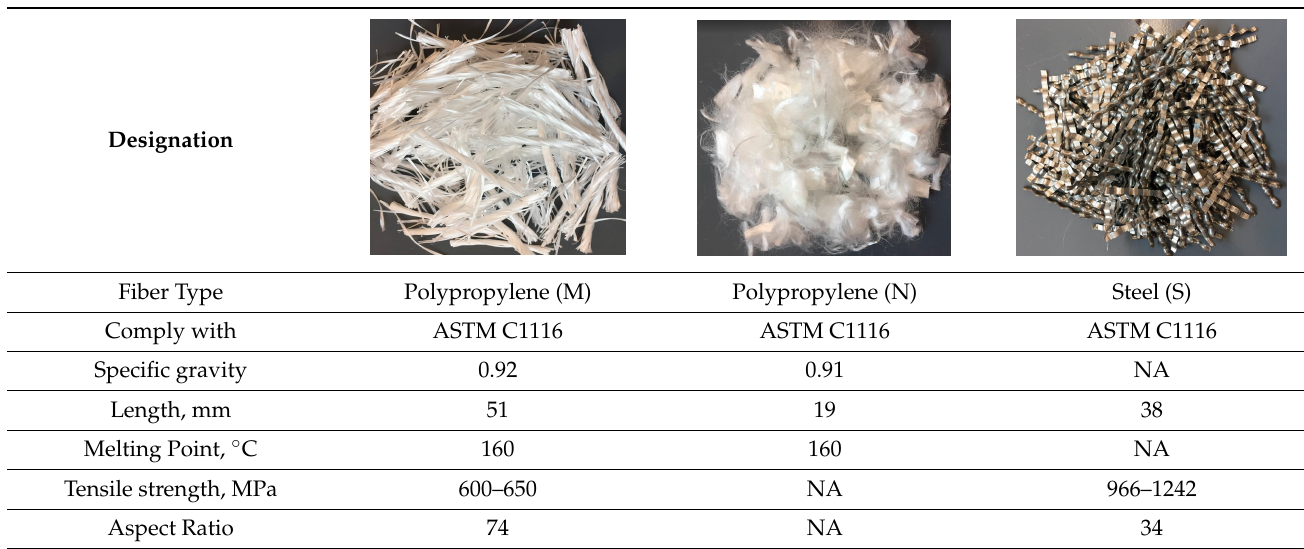
Table 1. Properties of fibers utilized in this study.